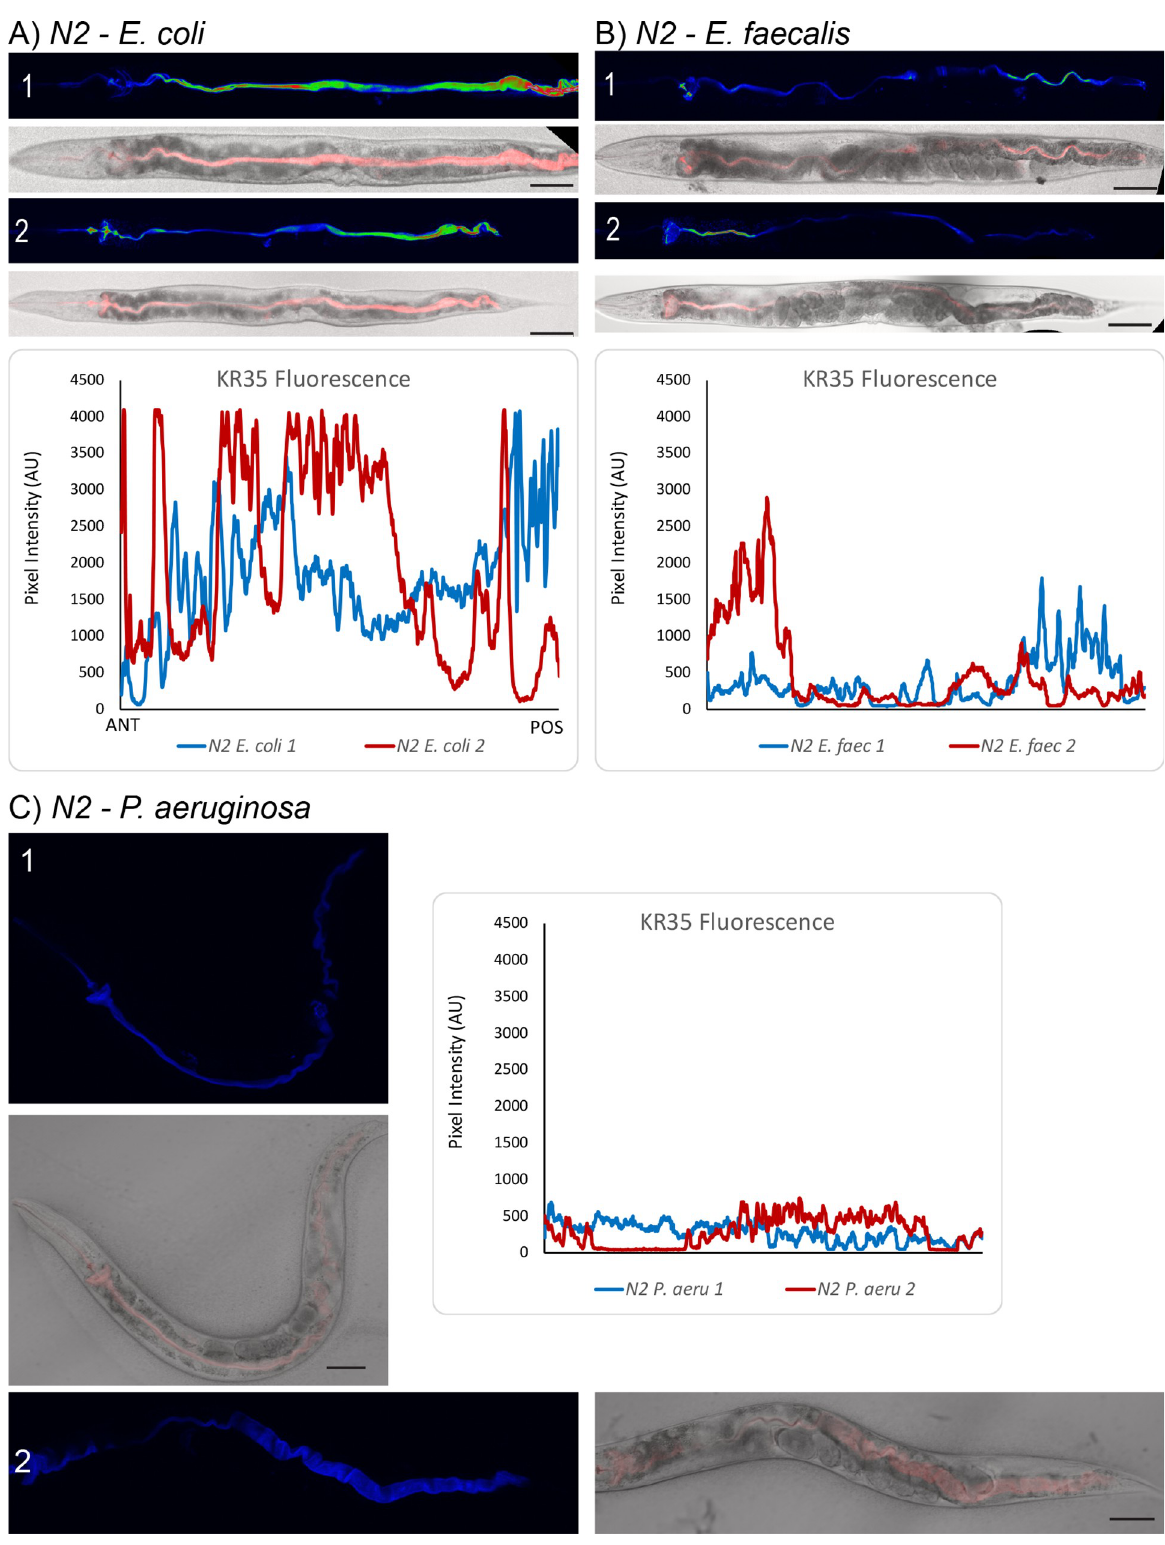
Fig 5. Pathogen ingestion results in intestinal neutralization in wild-type animals. We used laser-scanning confocal microscopy to assess KR35 fluorescence in N2 animals fed E . coli (A), E . faecalis (B) or P . aeruginosa (C). Below the panels for each pathogen is a plot of the pixel intensity of a